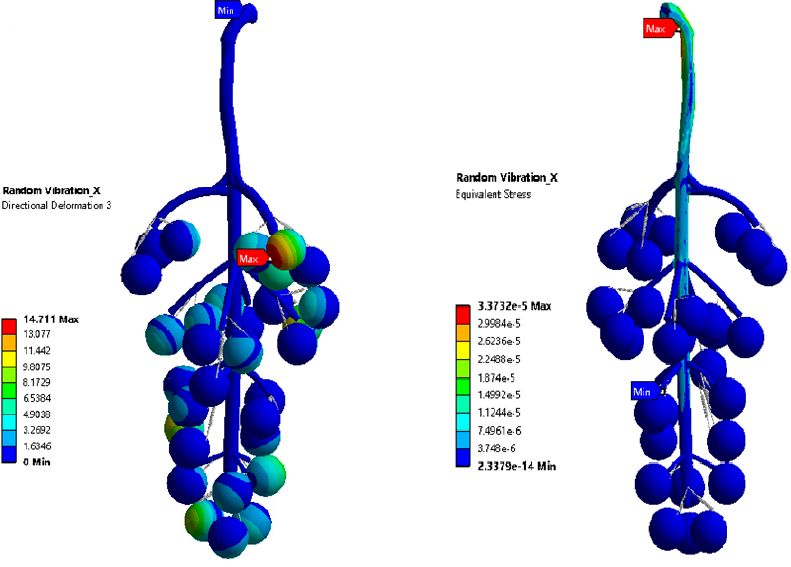
Figure 7. Vibration response in the X direction.